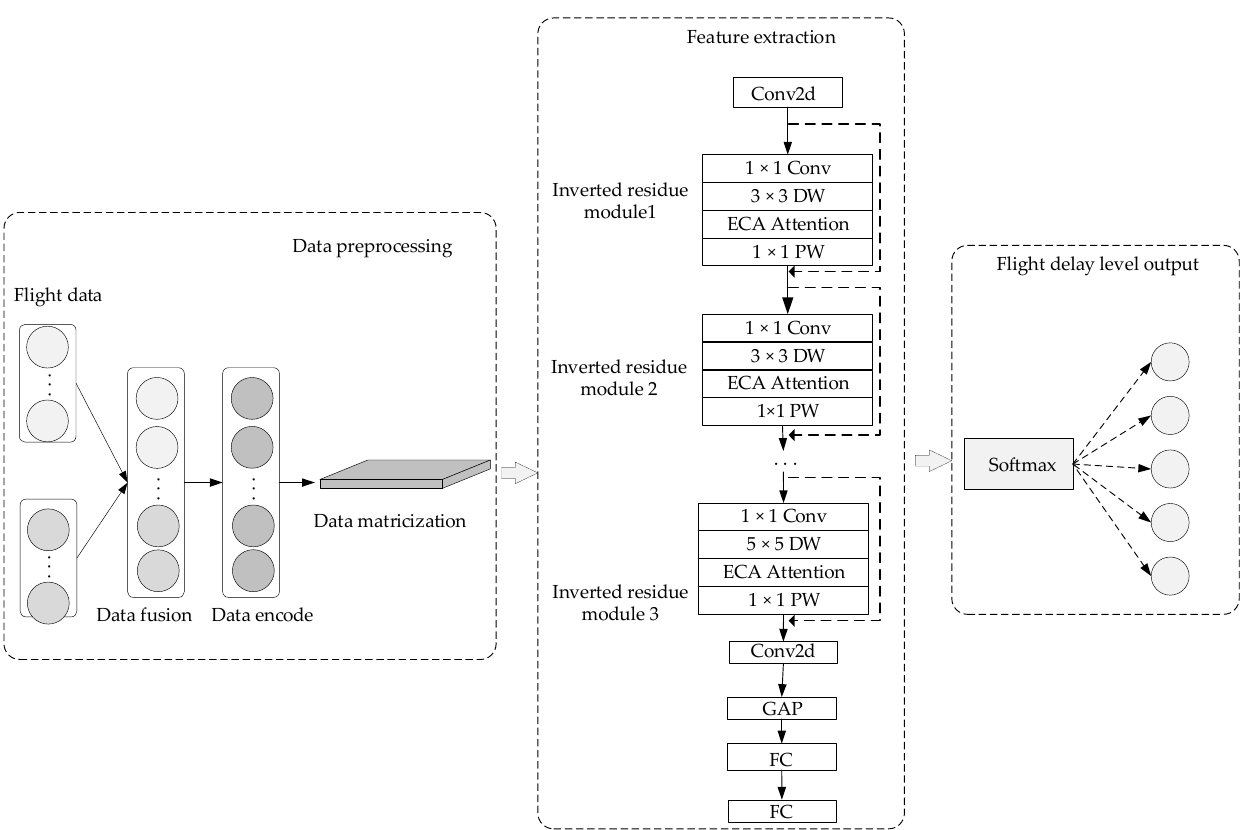
Figure 3. Flight delay prediction model based on the ECA-MobileNetV3 algorithm.